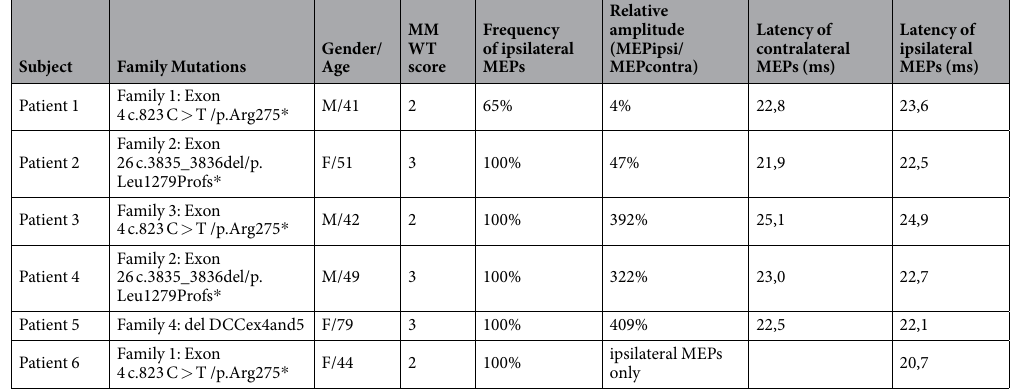
Table 1. Frequency, amplitude and latency of the ipsilateral MEPs in DCC -CMM patients The frequency of ipsilateral MEPs represents the percentage of trials in which unilateral stimulation of the dominant